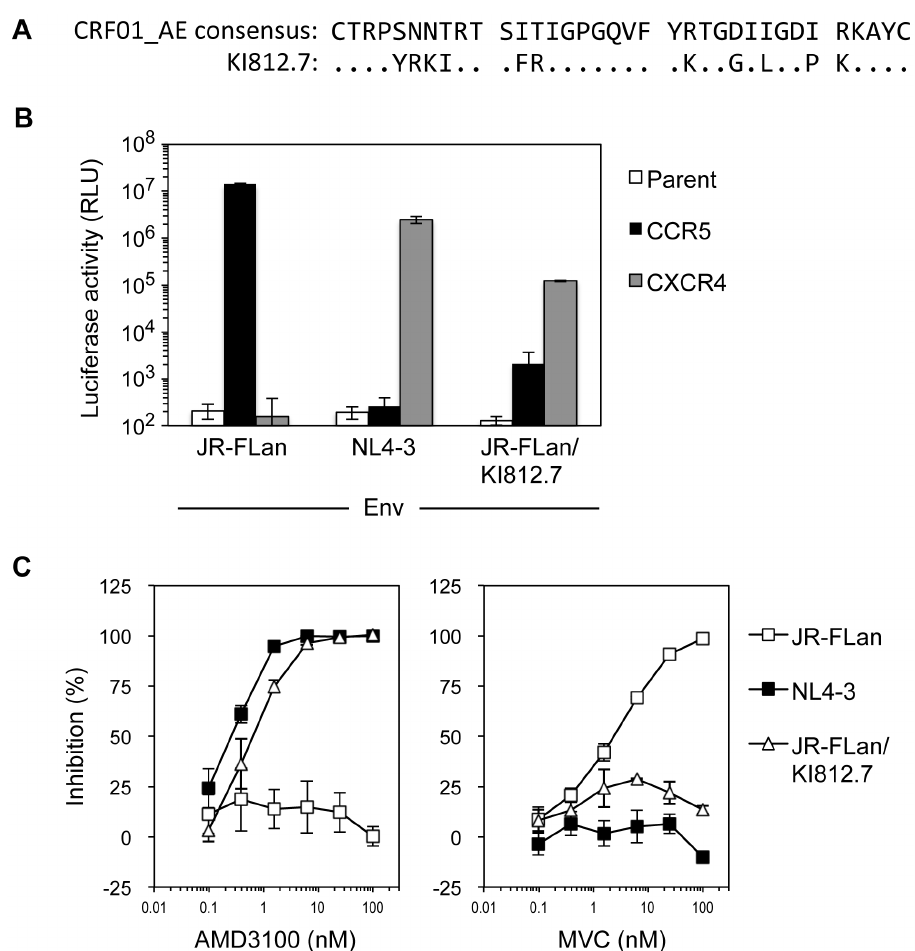
Figure 1. Virological characterization of HIV-1 carrying the V3 loop from CRF01_AE KI812.7. (A) V3 loop amino acid sequences of CRF01_AE consensus and KI812.7. Dots denote sequence identity. (B) Coreceptor usage of JR-FLan carrying the V3 loop from KI812.7. NP2/CD4 cells and NP2/CD4 cells expressing CCR5 or CXCR4 were infected with the same amount of luciferase-reporter pseudotyped virus (10 ng p24Ag). Luciferase activities were measured at 48 h post-infection. Data are the geometric means 6 SD of triplicate experiments. (C) Susceptibility of replication-competent HIV-1 JR-FLan/KI812.7 . TZM-bl cells were infected with replication-competent virus in the presence of AMD3100 or maraviroc (MVC), and then the luciferase activities of the infected cells were measured at 48 h post-infection. Data represent the extent of inhibition of replication relative to that in the absence of AMD3100 or MVC.